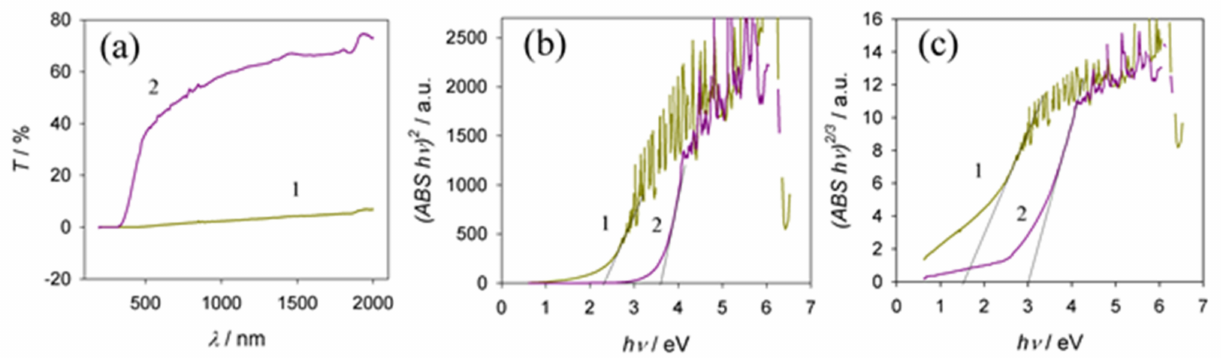
Figure 9. The transmission spectra ( a ) and calculated Tauc dependencies for direct ( b ) and direct forbidden transitions ( c ) in aluminum oxide samples obtained by Al anodization in 0.2 mol · L − 1 NaVO 3 + 0.8 mol · L − 1 HCOOH electrolyte (pH = 2.6) at 80 V before (1) and after calcination at 950 ◦ C for 2 h